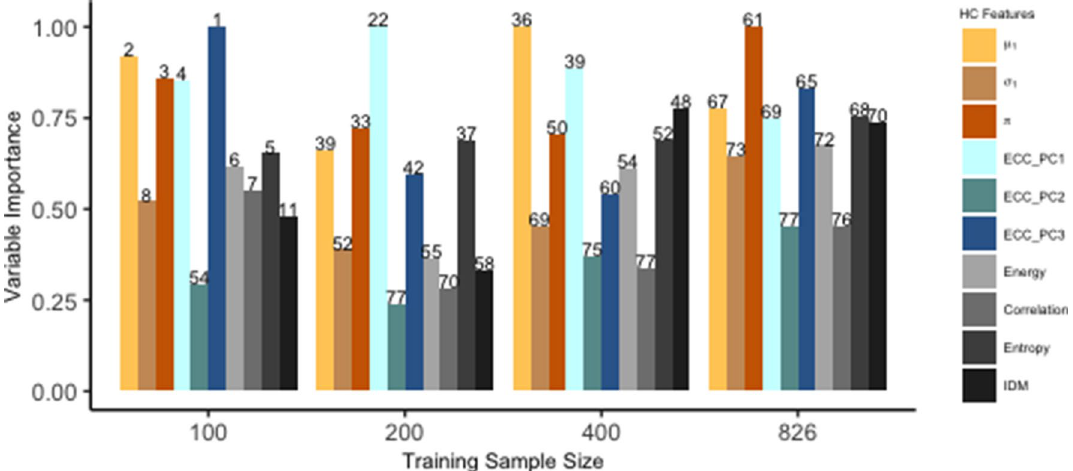
Figure 8. Variable importance summary of HC features in RF classifiers with both HC and CNN features included. Numbers above color bars represent ranks of importance among all